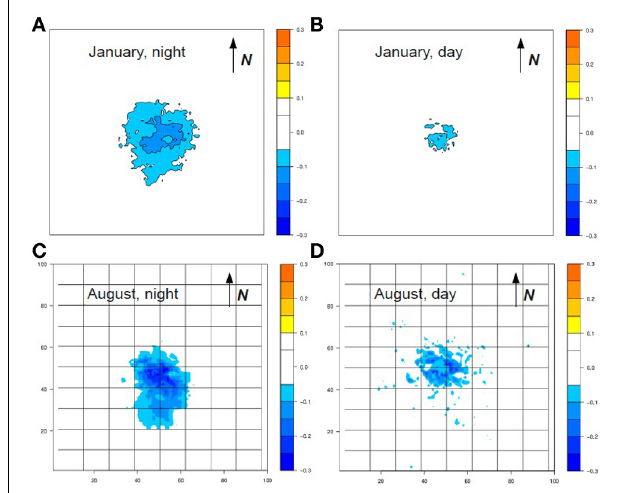
FIGURE 3 | Difference of minimum or maximum air temperature between simulations with and without solar panels. Each panel (A–D) is a monthly average. Horizontal and vertical axes are in